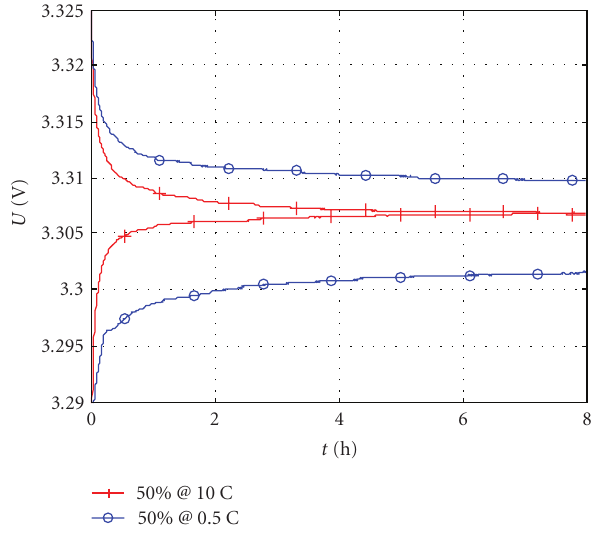
Figure 5: Progress of the cell voltage during rest over 8 hour, where the SOC = 50% is adjusted through charging and discharging with various current